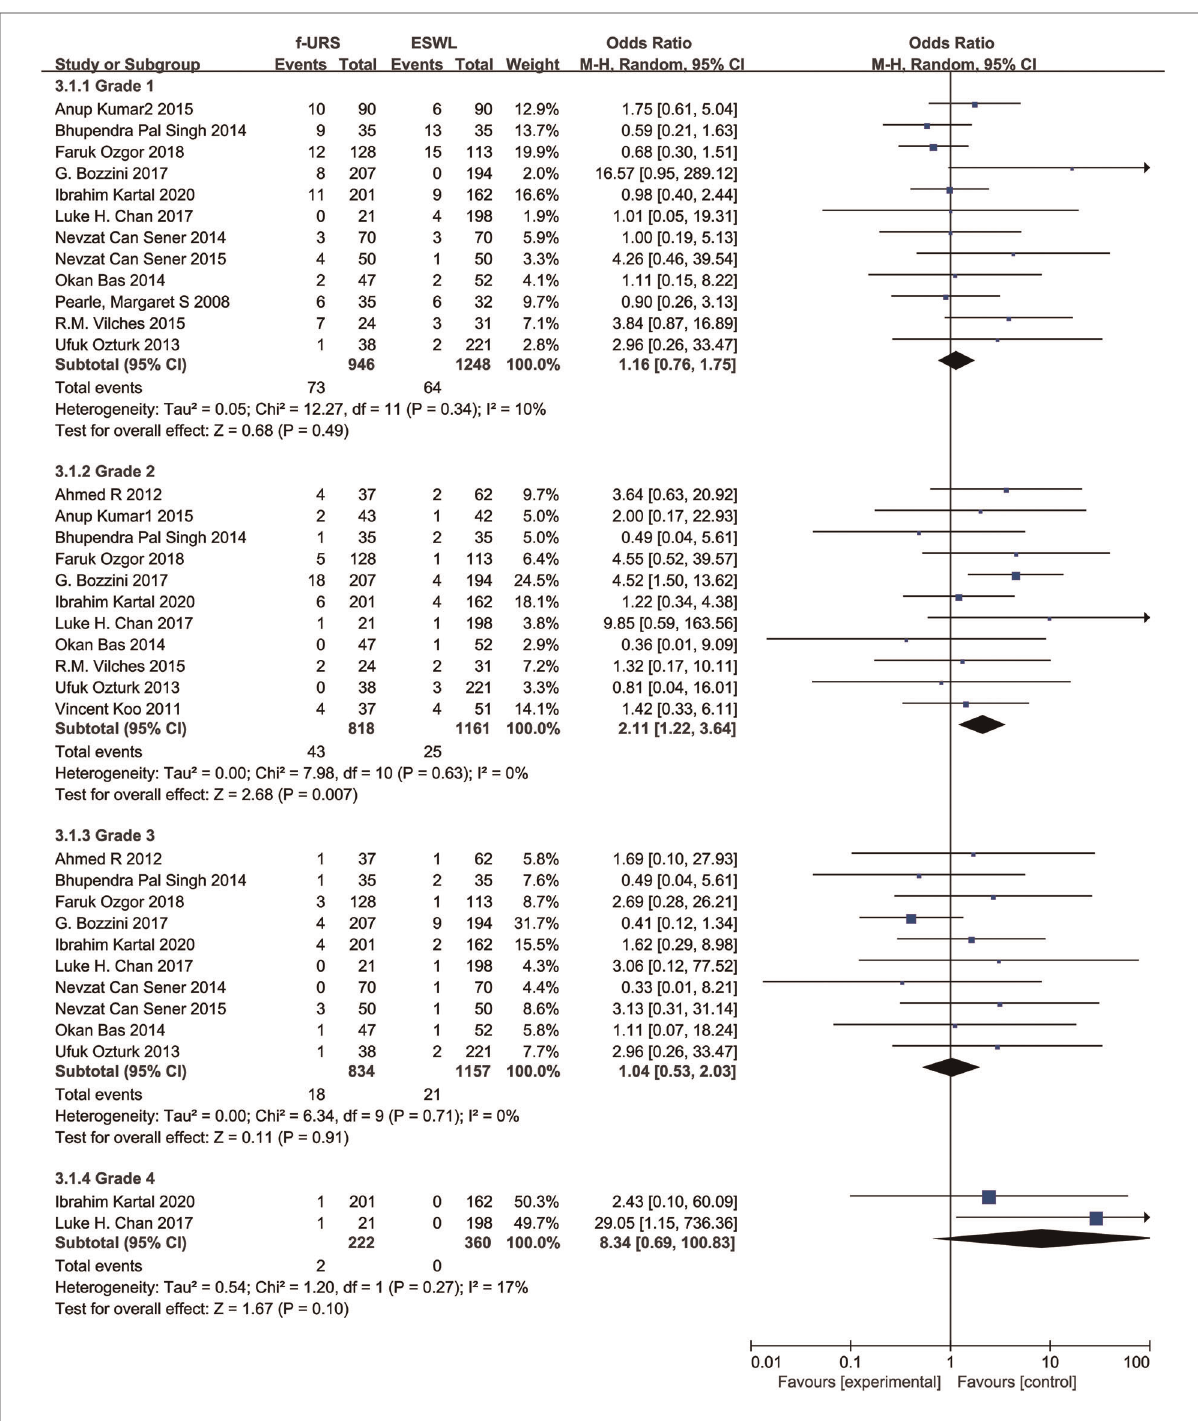
FIGURE 11 Subgroups analysis of complications graded by the Clavien – Dindo classi fi cation for f-URS and